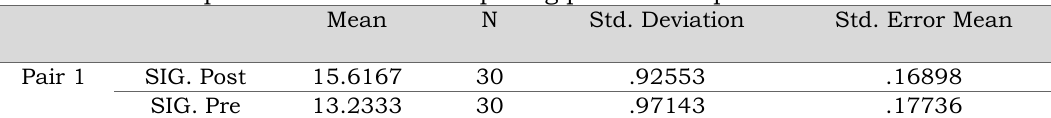
Table 3. descriptive statistics for comparing pretest and posttest scores of the